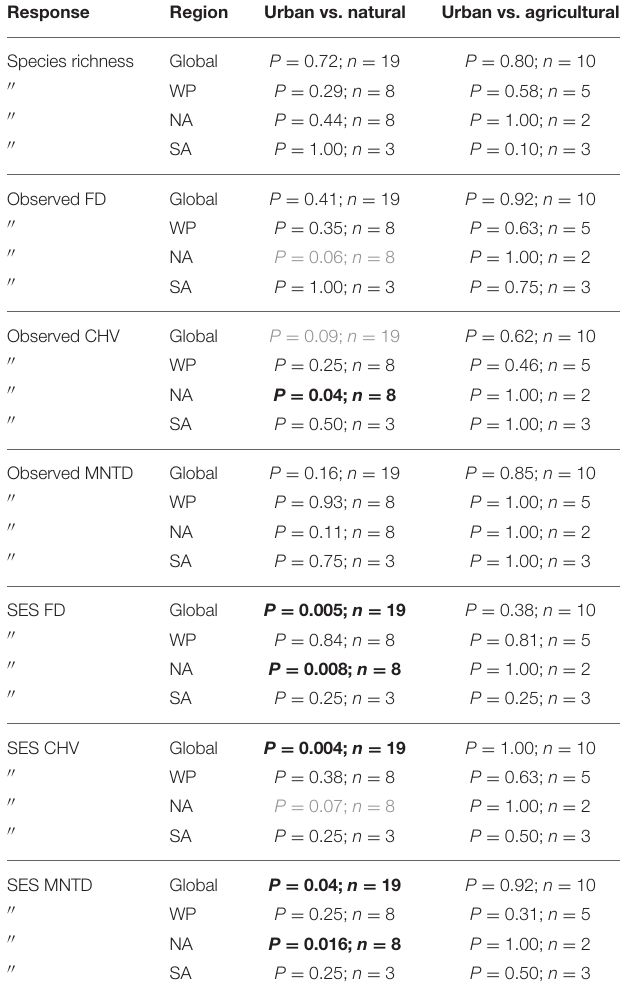
TABLE 2 | Results of paired tests for differences in species richness, observed functional diversity metrics, and standardized effect size (SES) functional diversity metrics that take species richness into account between paired urban avian assemblages and those in natural habitats, and between paired urban and agricultural assemblages.